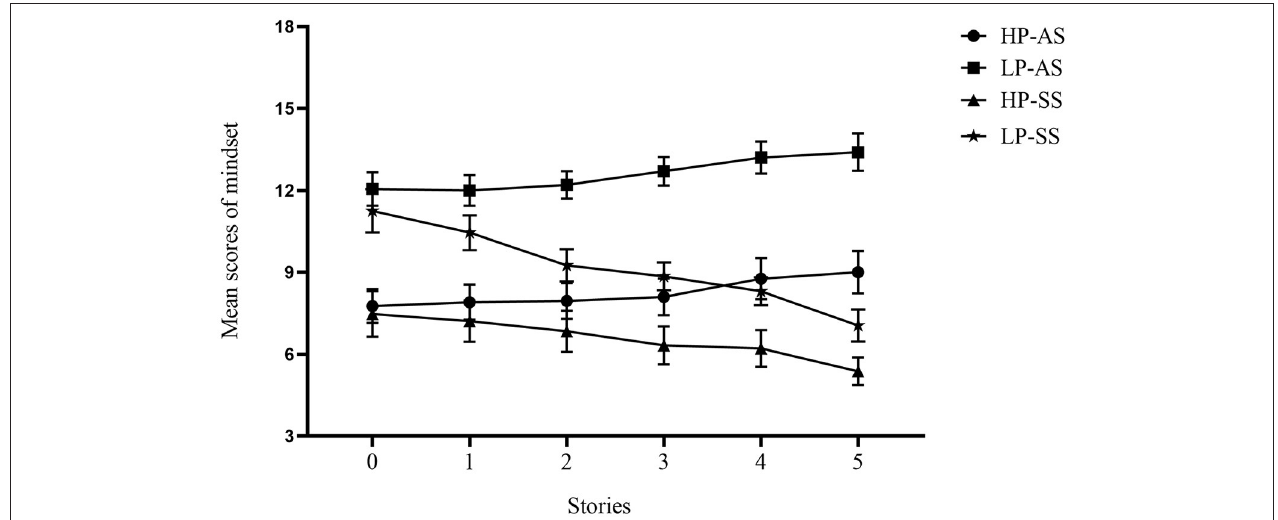
FIGURE 2 | The mindset scores of undergraduates with high and low perseverance after reading five struggle or five achievement stories. Error bars represent standard error. Number of stories: the number of stories participants have read. HP-AS group: a high-perseverance group that read achievement stories of role models. LP-AS group: a low-perseverance group that read achievement stories of role models. HP-SS group: a high-perseverance group that read struggle stories of role models. LP-SS group: a low-perseverance group that read struggle stories of role models.